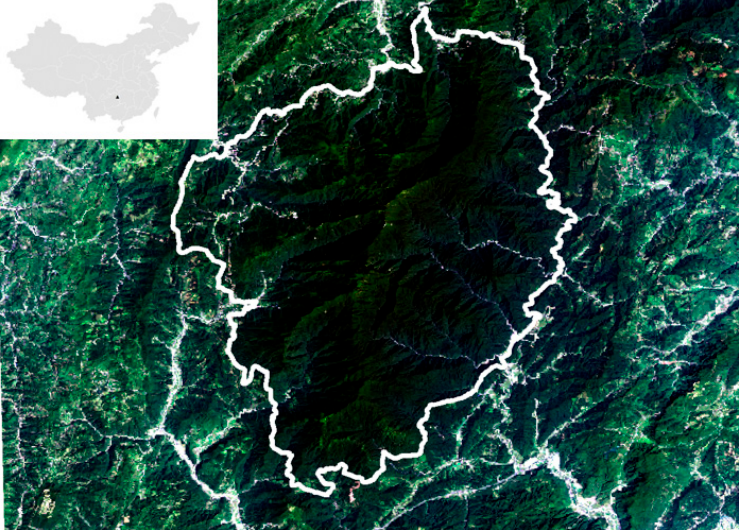
Figure 1. True color image of Fanjingshan National Nature Reserve; boundary in white.